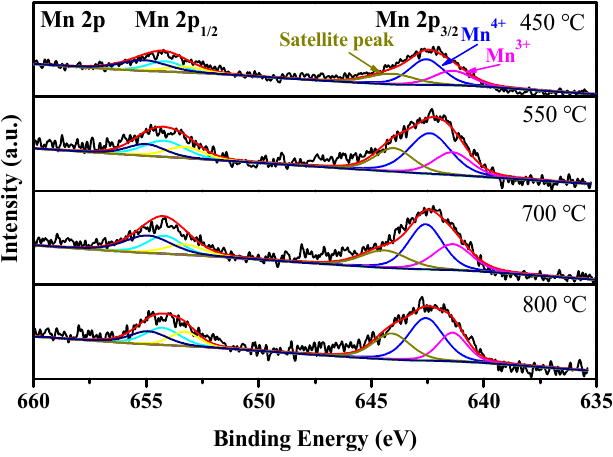
Figure 10. XPS spectra of Mn 2p over different catalysts.